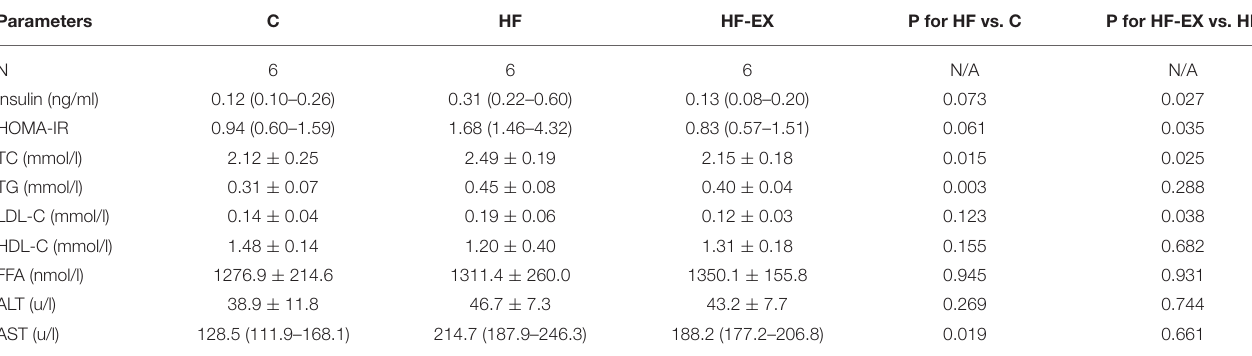
TABLE 1 | Serum biochemical parameters of male offspring aged 24 weeks. Parameters